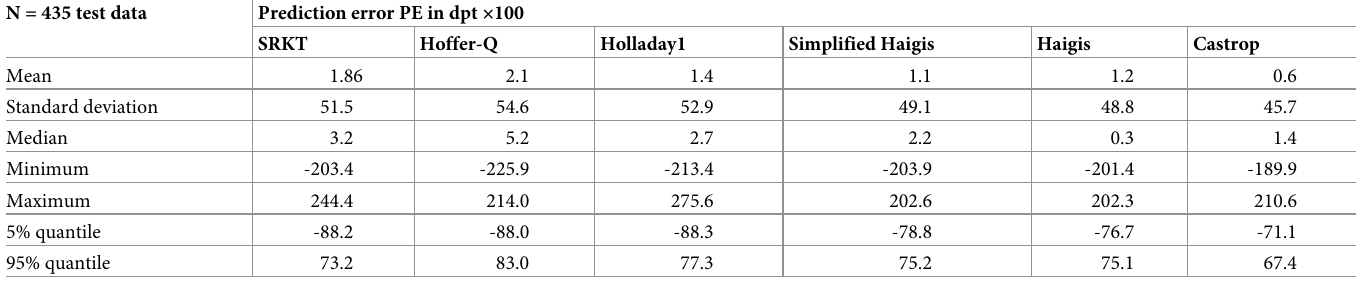
Table 2. Prediction error ( × 100) as the difference between achieved spherical equivalent and formula predicted spherical equivalent for the formulae under test. N = 435 test